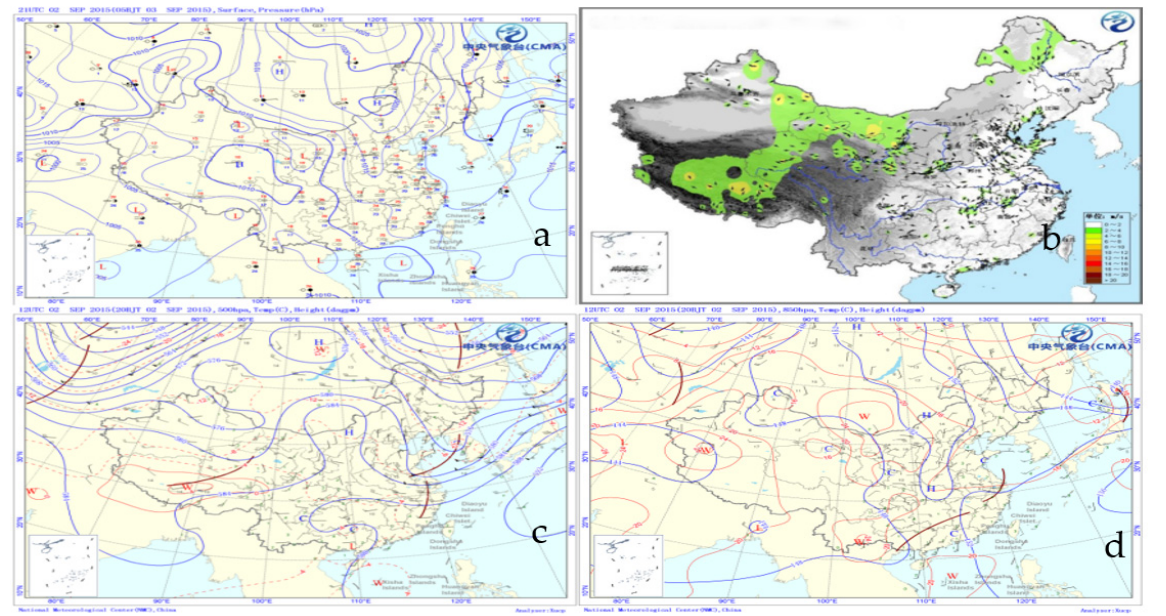
Figure 4. Maps of the weather and AQI situation at 07:00 on 2 September in 2015. Notes: ( a , c , d ) shows the map of the surface, 500 hPa height, 850 hPa height, respectively. ( b ) shows the automatic ground observation of 1 h wind field at 07:00 on 2 September in 2015.